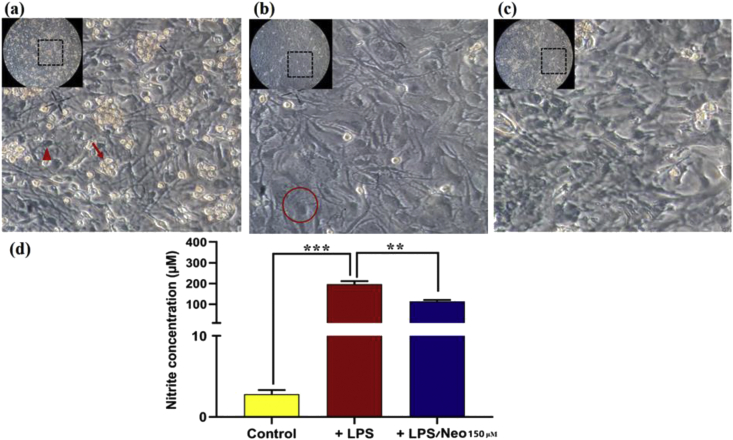
NO• production in LPS-induced glial cells in the presence or absence of neobaicalein. (a) The morphology of mixed glial cultures (control) shows the basal layer of astrocytes. The dark-field oligodendrocyte precursor cells (triangle) adhere to the top of astrocytes, and small bright-field microglia (arrow) are rounded and floating. (b) The LPS-stimulated cells show different morphology. Most of them lose their spindle shapes, become flattened, and are not branched anymore (circle). (c) The natural morphology of the cells in the presence of neobaicalein/LPS is better preserved than the LPS-stimulated one (inserts are the whole lens of the camera, and part of it is magnified). (d) Nitrite level in the primary mixed glial cells after 48 h of treatment was measured using Griess reagent at 540 nm based on a standard curve of sodium nitrite. Values indicate the mean ± SD of three independent experiments. The symbols ∗∗ and ∗∗∗ indicates significance between the control group and experimental groups at P ≤ 0.01 and P ≤ 0.001, respectively.